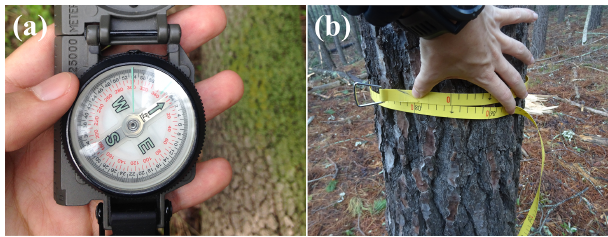
Figure 5. (a) Measure of the fall direction of a tree and (b) mea- sure of trunk diameter during the damage survey of an EF1 tornado on 13 October 2016 in Llinars del Vallès (Catalonia) and an EF2 tornado on 7 January 2018 in Darnius (Catalonia), respectively (au- thor: Oriol